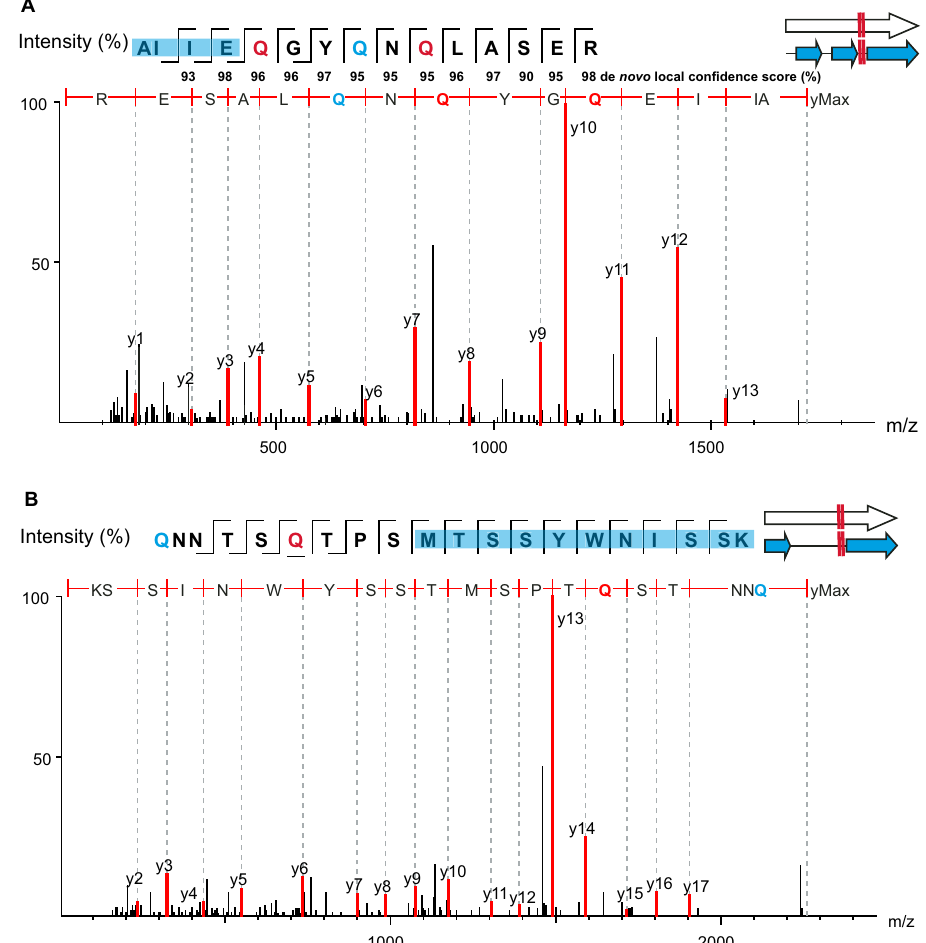
Fig. 3 | Example MS/MS spectra of alternative coding tryptic peptides. In all panels, red “ Q ” represents a stop codon that has been reassigned to glutamine usingcode15translation.Blue “ Q ” representscanonicalglutamineresidues.Note — theannotatedy-ionseriesarereadfromthec-terminustothen-terminus.(topleft) Residues highlighted in blue on the amino acid sequence fragmentation ladder